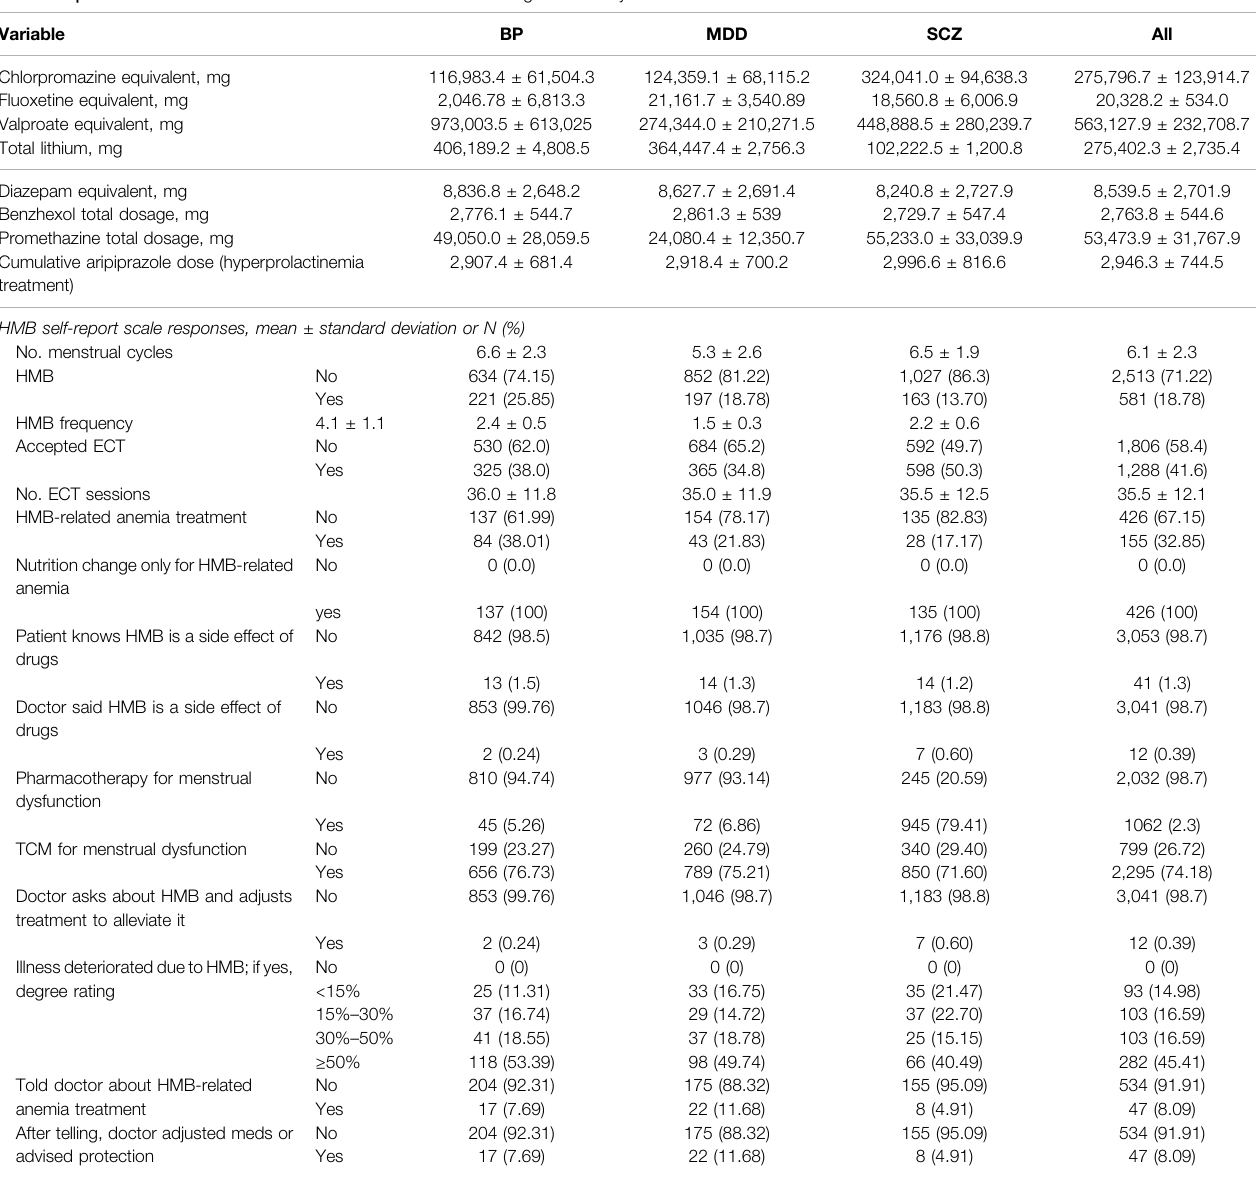
TABLE 2 | Treatment information within the 18 months before enrolling in the